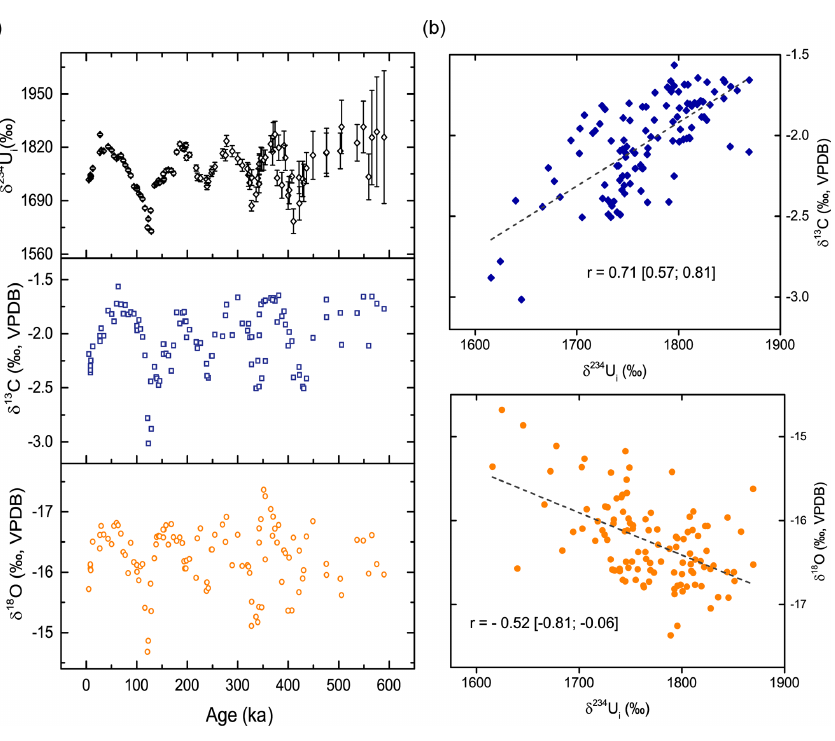
Figure 1. (a) Plots of DH2 230 Th-derived δ 234 U i , δ 13 C, and δ 18 O over the last 590kyr; (b) scatter plots between DH2 230 Th-derived δ 234 U i and δ 13 C, and 230 Th-derived δ 234 U i and δ 18 O, respectively. Correlation coefficients ( r ) with 95% calibrated confidence intervals and fitting curve (dashed lines) are